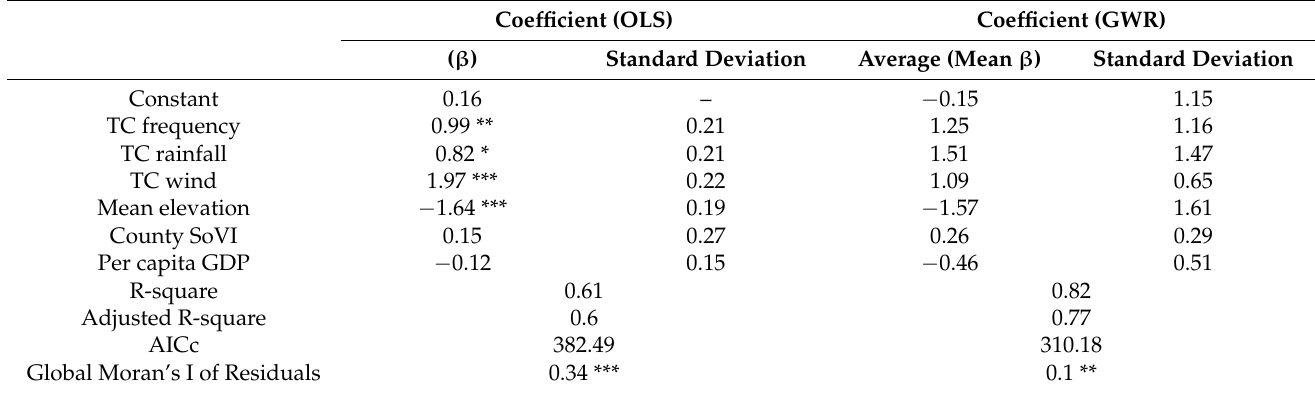
Table 1. Influence of six selected factors on TC-related property damage in inland counties using OLS and GWR